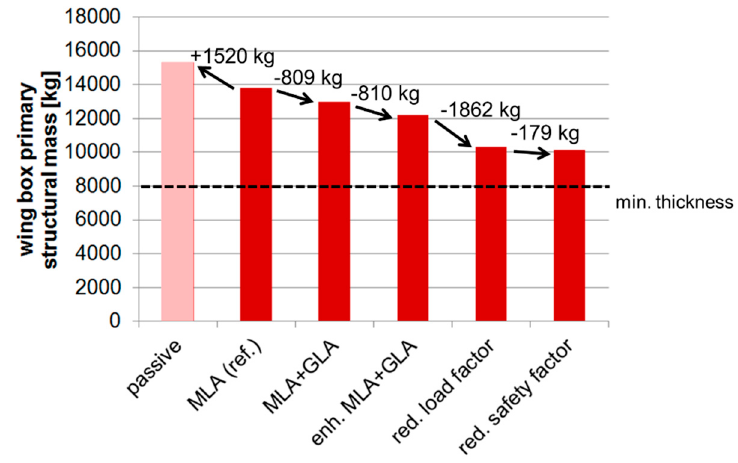
Figure 48. Overview of the wing box mass reduction.